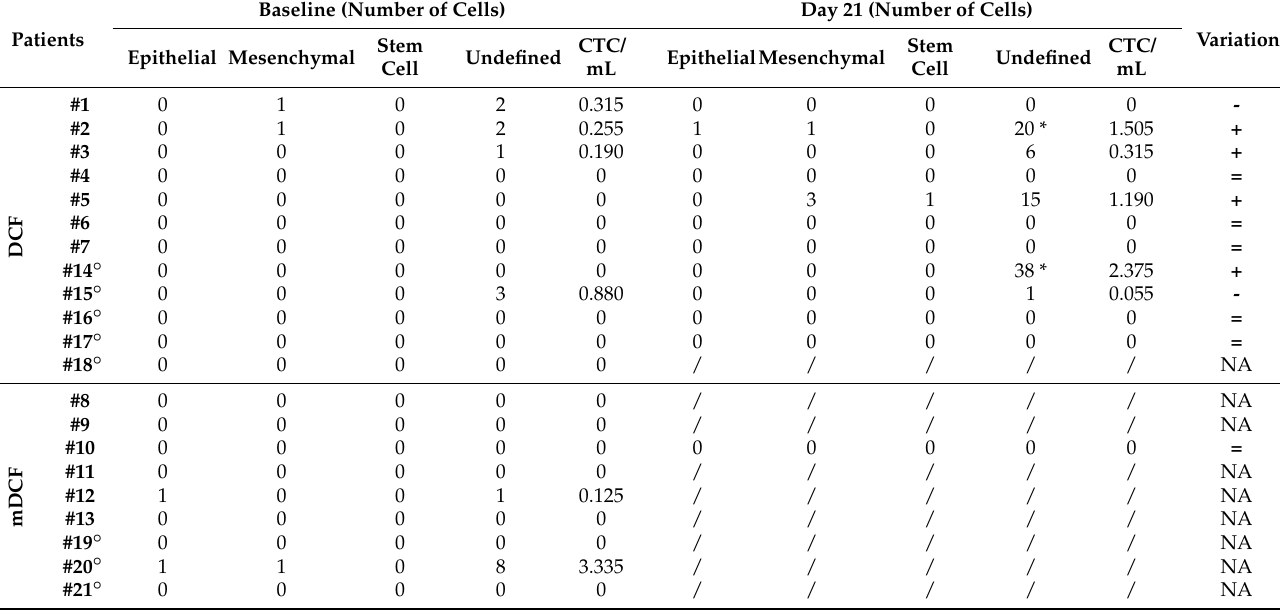
Table 2. Identification and characterization of CTC patients according to treatment protocol.